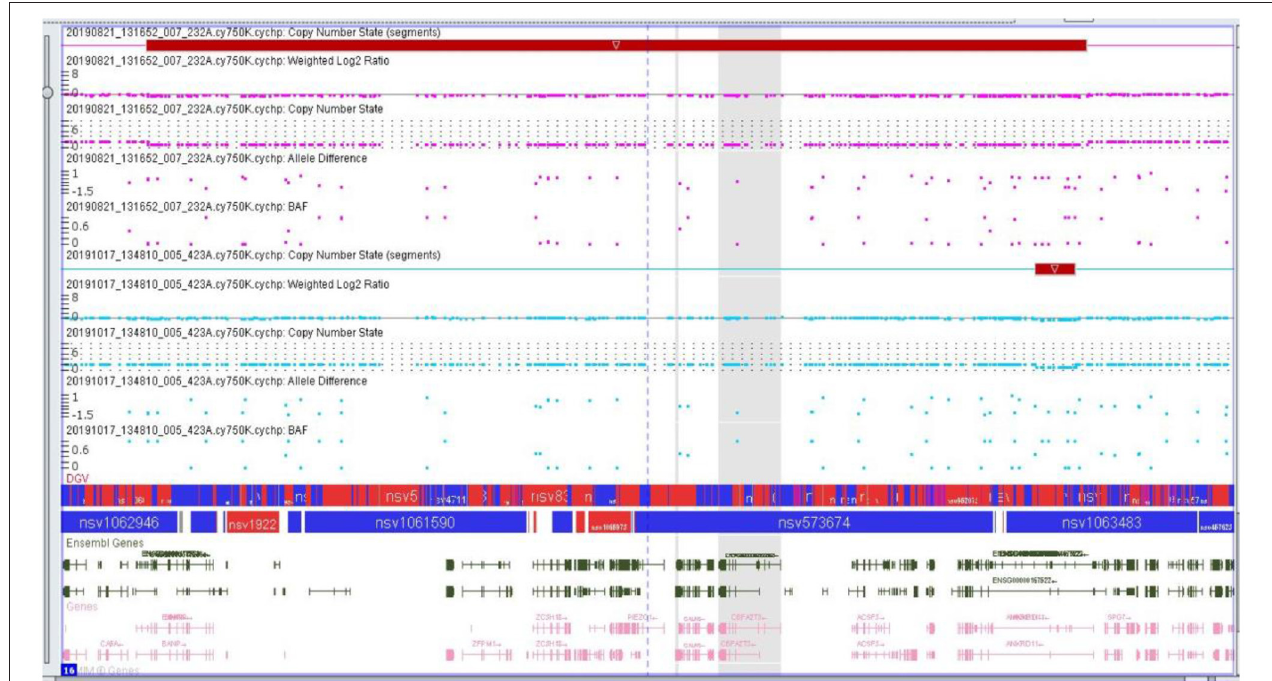
FIGURE 6 | Microarray result of the second proband showing genomic imbalance- deletion in the 16q24.2q24.3 chromosome region.